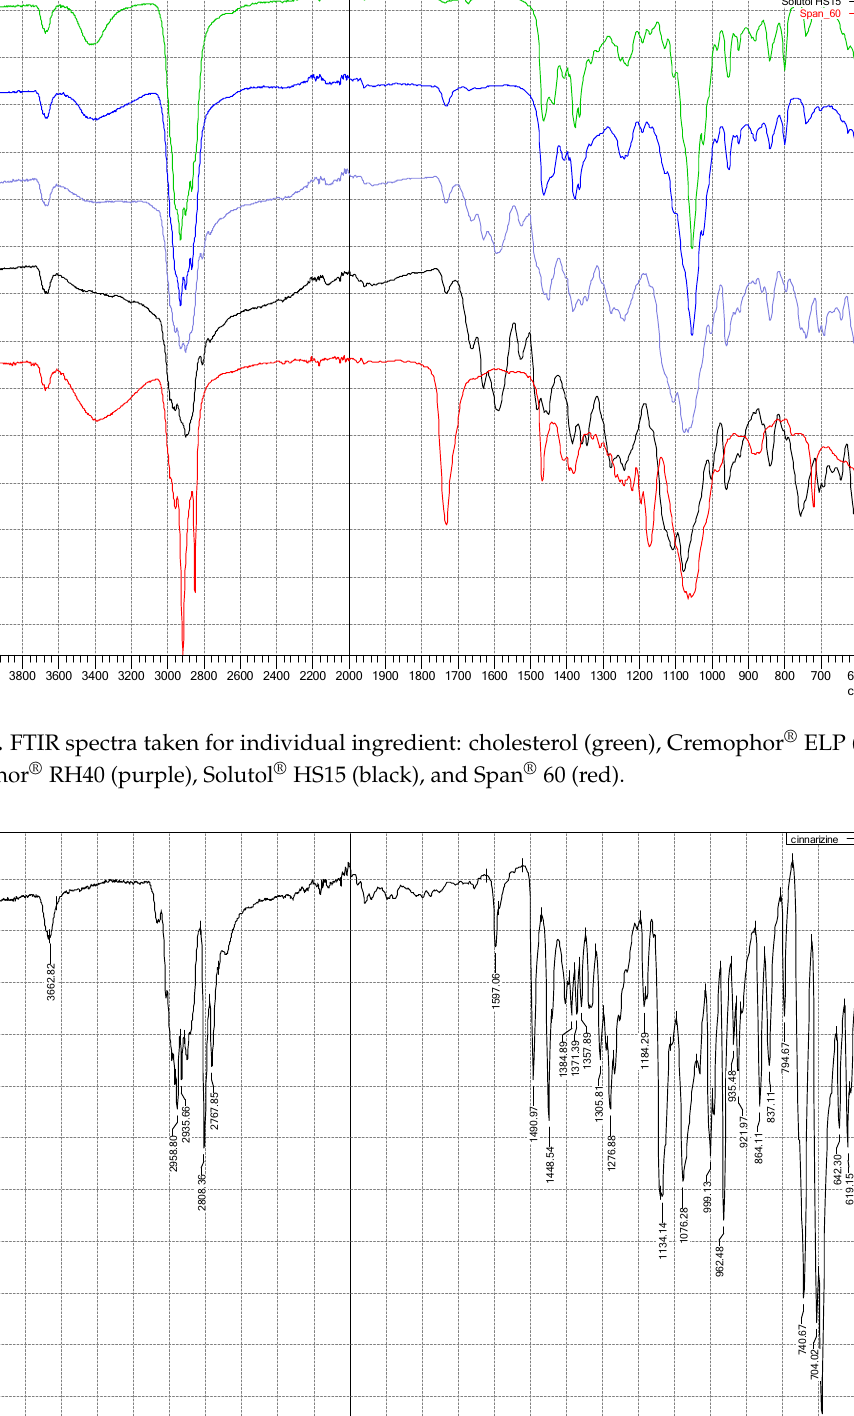
Figure 5. FTIR spectrum of cinnarizine pure drug. Table 5. Principal peaks with assignments of cinnarizine pure drug.